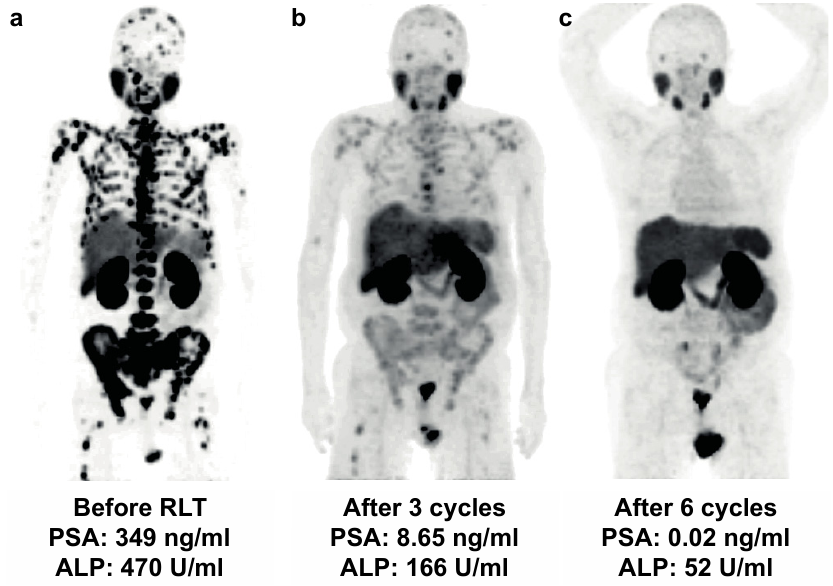
Figure 3. Maximum intensity projections of 68 Ga-PSMA-11 PET/CT imaging in a 69-year-old patient at the baseline ( a ), upon interim staging ( b ), with excellent treatment response after 6 cycles of 177 Lu-PSMA-617 after 46.3 GBq of cumulative treatment activity ( c ).